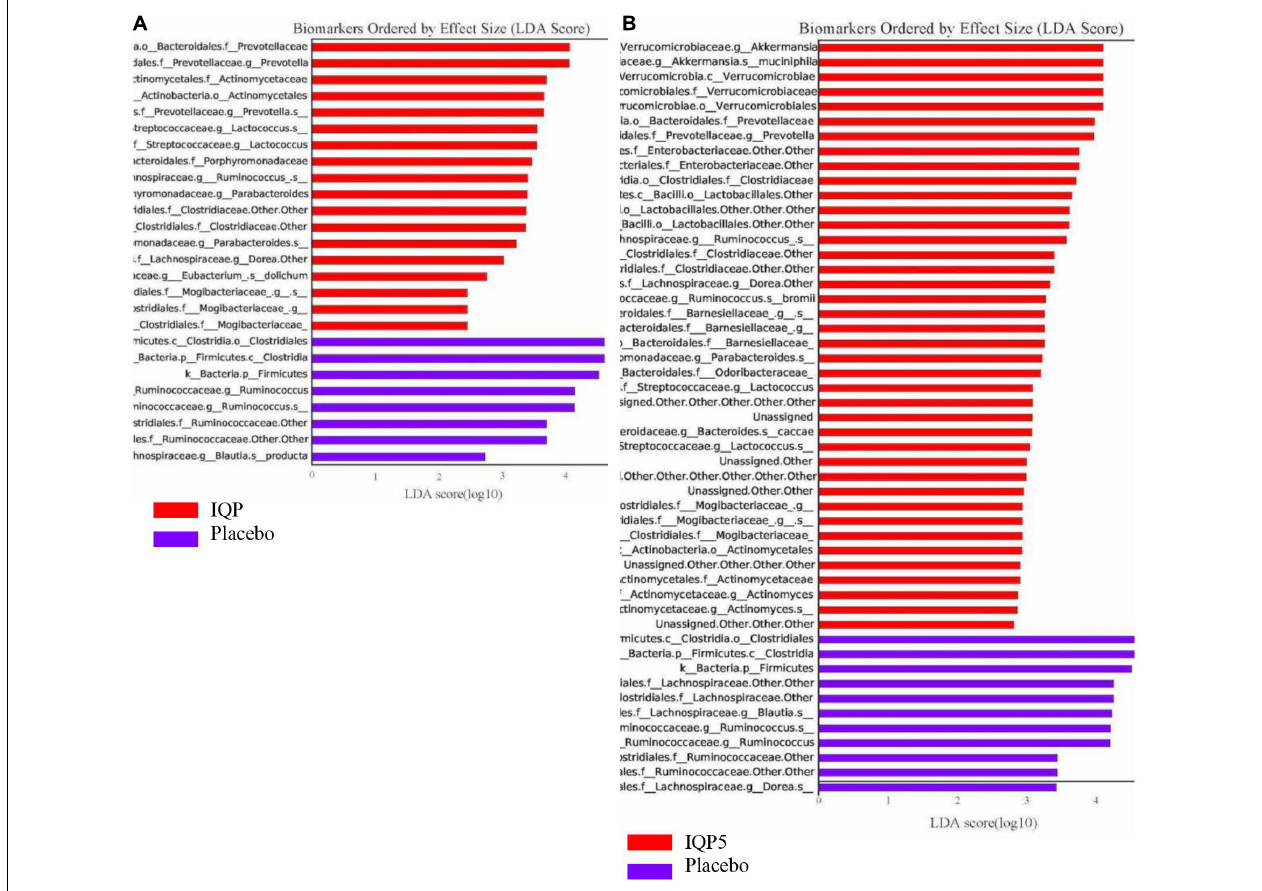
FIGURE 3 | Histogram of linear discriminant analysis (LDA) scores showing the taxa abundance distribution of each microbiota classification with a statistical difference after 12 weeks. Bars in red indicate higher abundance in the IQP and IQP5 groups, while purple bars indicate higher abundance in the placebo group.